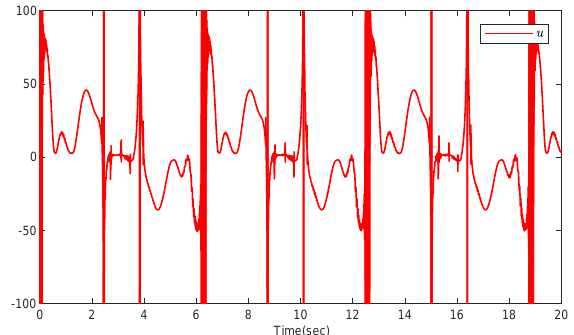
Figure 10. Control input u